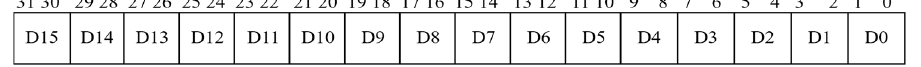
Figure 3. The DACR register, each memory region is assigned 2 Bits.